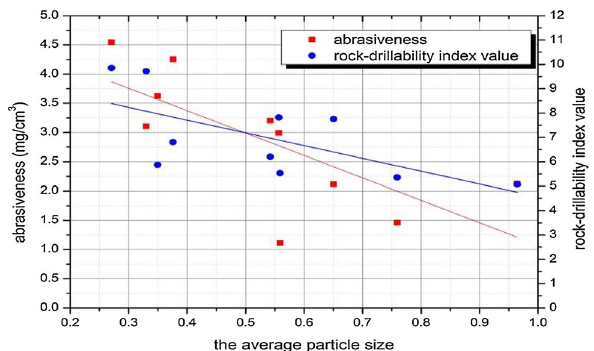
Fig. 6 The impact of the average particle size on rock drillability and abrasiveness